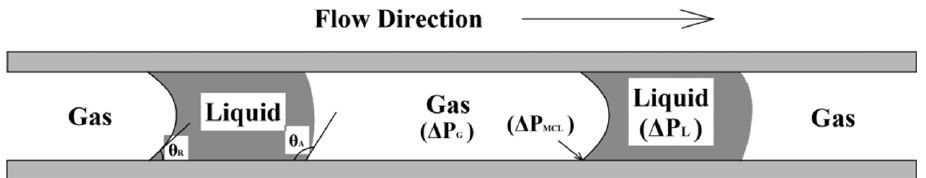
Figure 6. Deformation of the static liquid section slug in a circular tube by force.